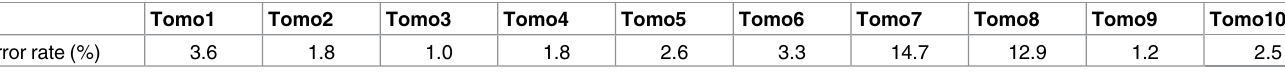
Table 2 contains single error rates for every zebrafish tomogram. The error rate is defined as: false negatives (FN) / number of vesicles in the